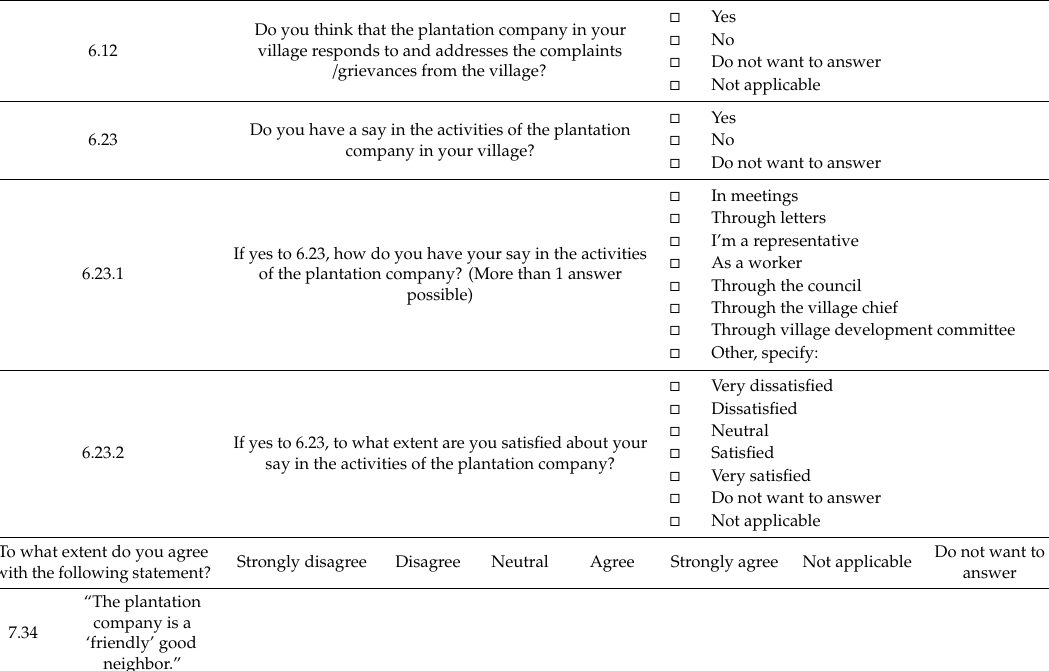
Table A1. Excerpt of Survey Questions from Household